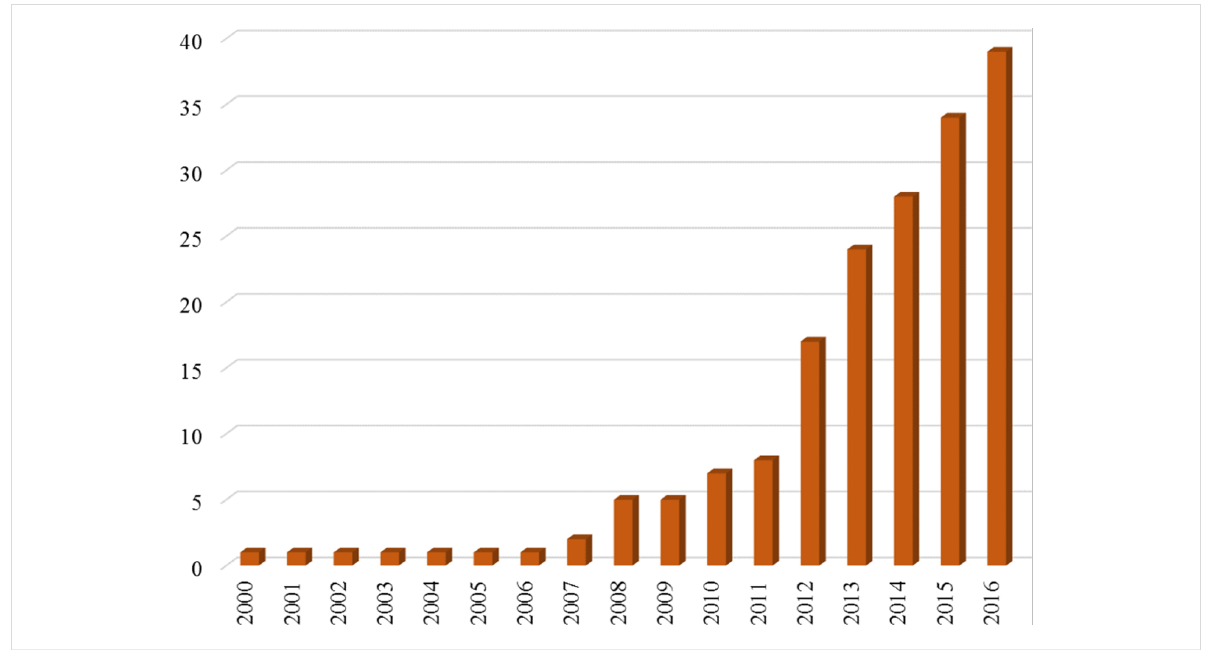
Figure 1: The cumulative number of different GPCRs for which X-ray structures were available in a given year. The data represent a total of 174 structures on 91 ligand–receptor complexes for 39 different receptors. The data are taken from http://gpcrdb.org/structure/statistics (2nd February